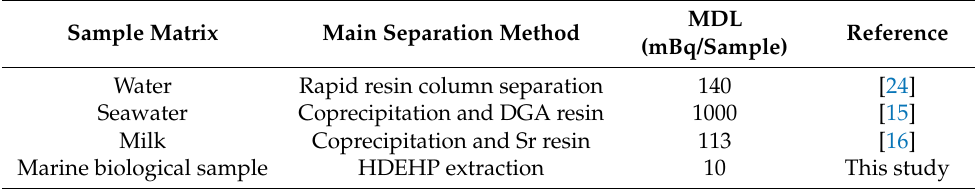
Table 3. MDLs of selected radiochemical procedures for 90 Sr determination in different sample ma- trices.